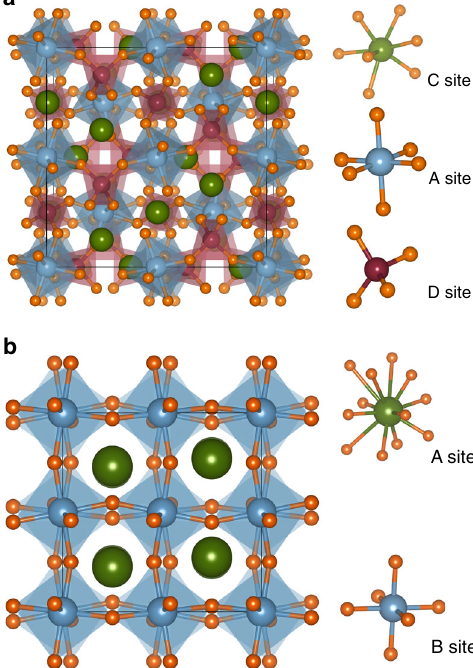
Fig. 1 Crystal structures of garnet and perovskite prototypes. a Crystal structure of Ia 3 d C 3 A 2 D 3 O 12 garnet prototype. Green (C), blue (A), and red (D) spheres are atoms in the 24 c (dodecahedron), 16 a (octahedron), and 24 d (tetrahedron) sites, respectively. The orange spheres are oxygen atoms. b Crystal structure of Pnma ABO 3 perovskite prototype. Green (A) and blue (B) spheres are atoms in the 4 c (cuboctahedron) and 4